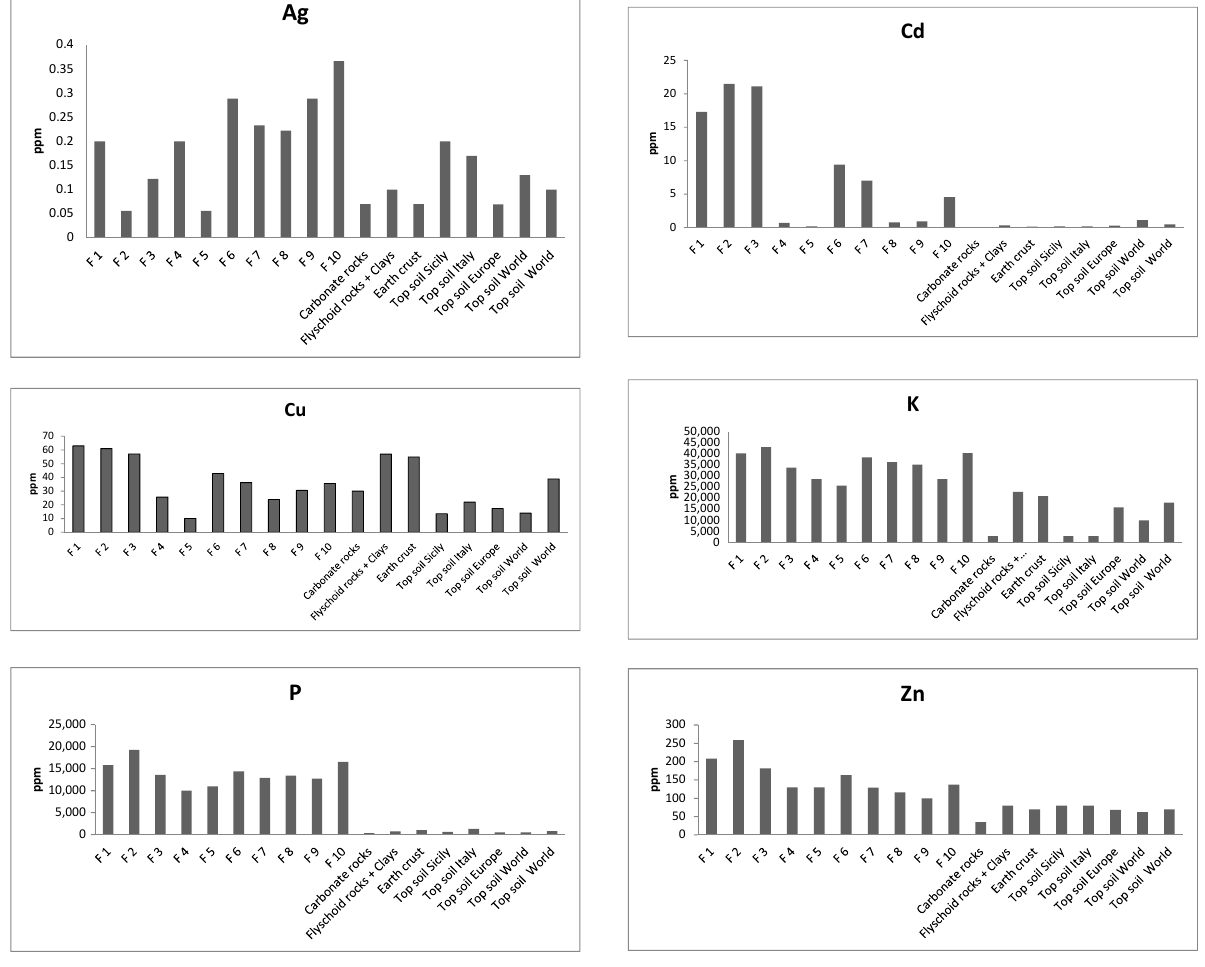
Fig. 4 Content of Ag, Cd, Cu, K, P, and Zn in mushroom samples (F1–10) and the rocks and soil